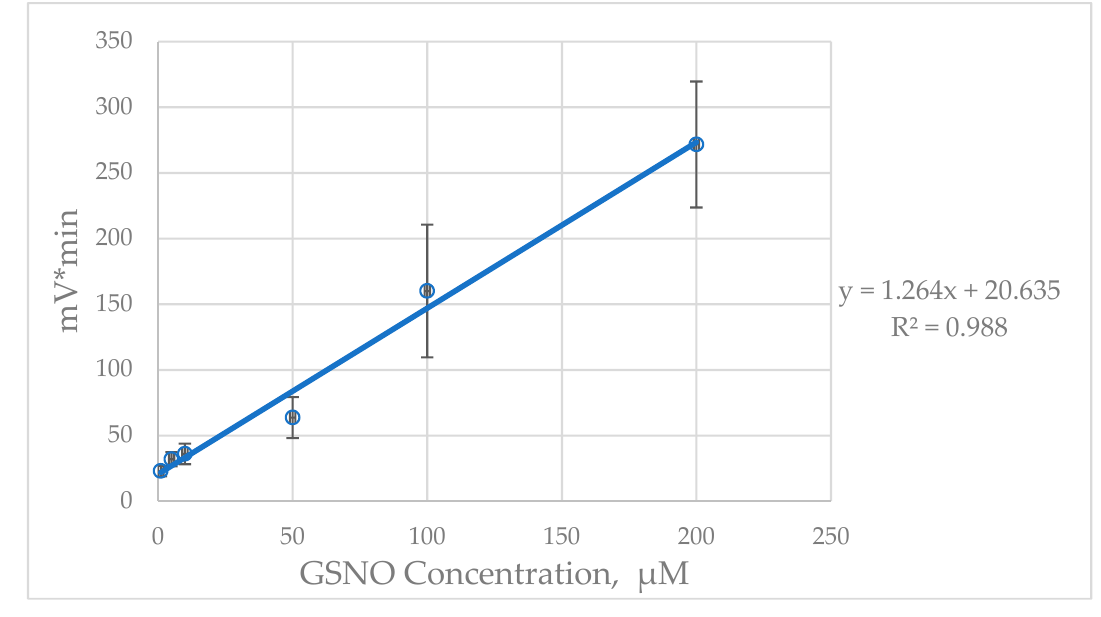
Figure 1. Principles of the UV probe development. (A). The assay uses focused UV light to cleave the S-N bond in the S -nitrosothiol molecules (photolysis) and release nitric oxide (NO). The NO, released from S -nitrosothiols [17], can diffuse through skin and other tissue to be recorded by the chemiluminescence device (here, the NOA280). ( B ). Structure of the S -Nitrosothiols studied.